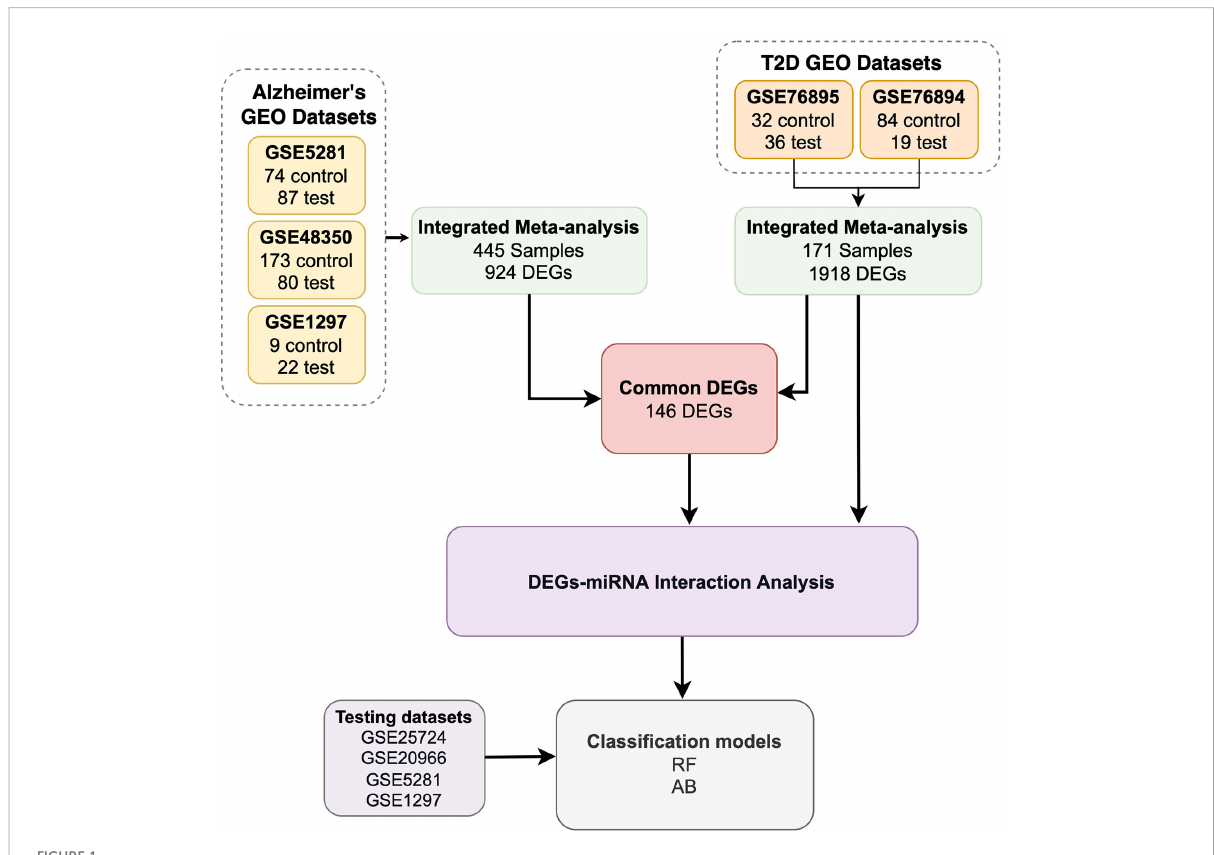
FIGURE 1 A fl owchart description of the study